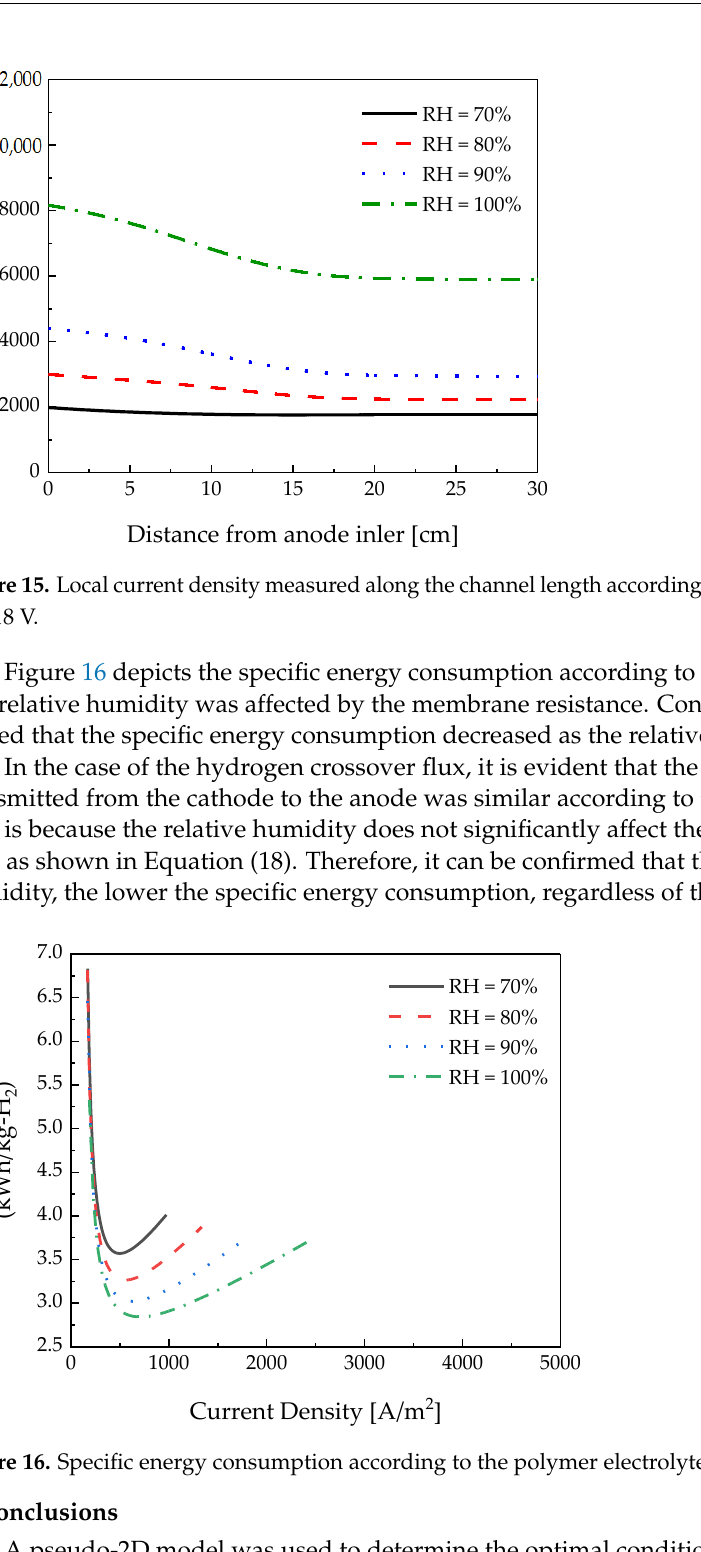
Figure 16. Specific energy consumption according to the polymer electrolyte membrane thickness.